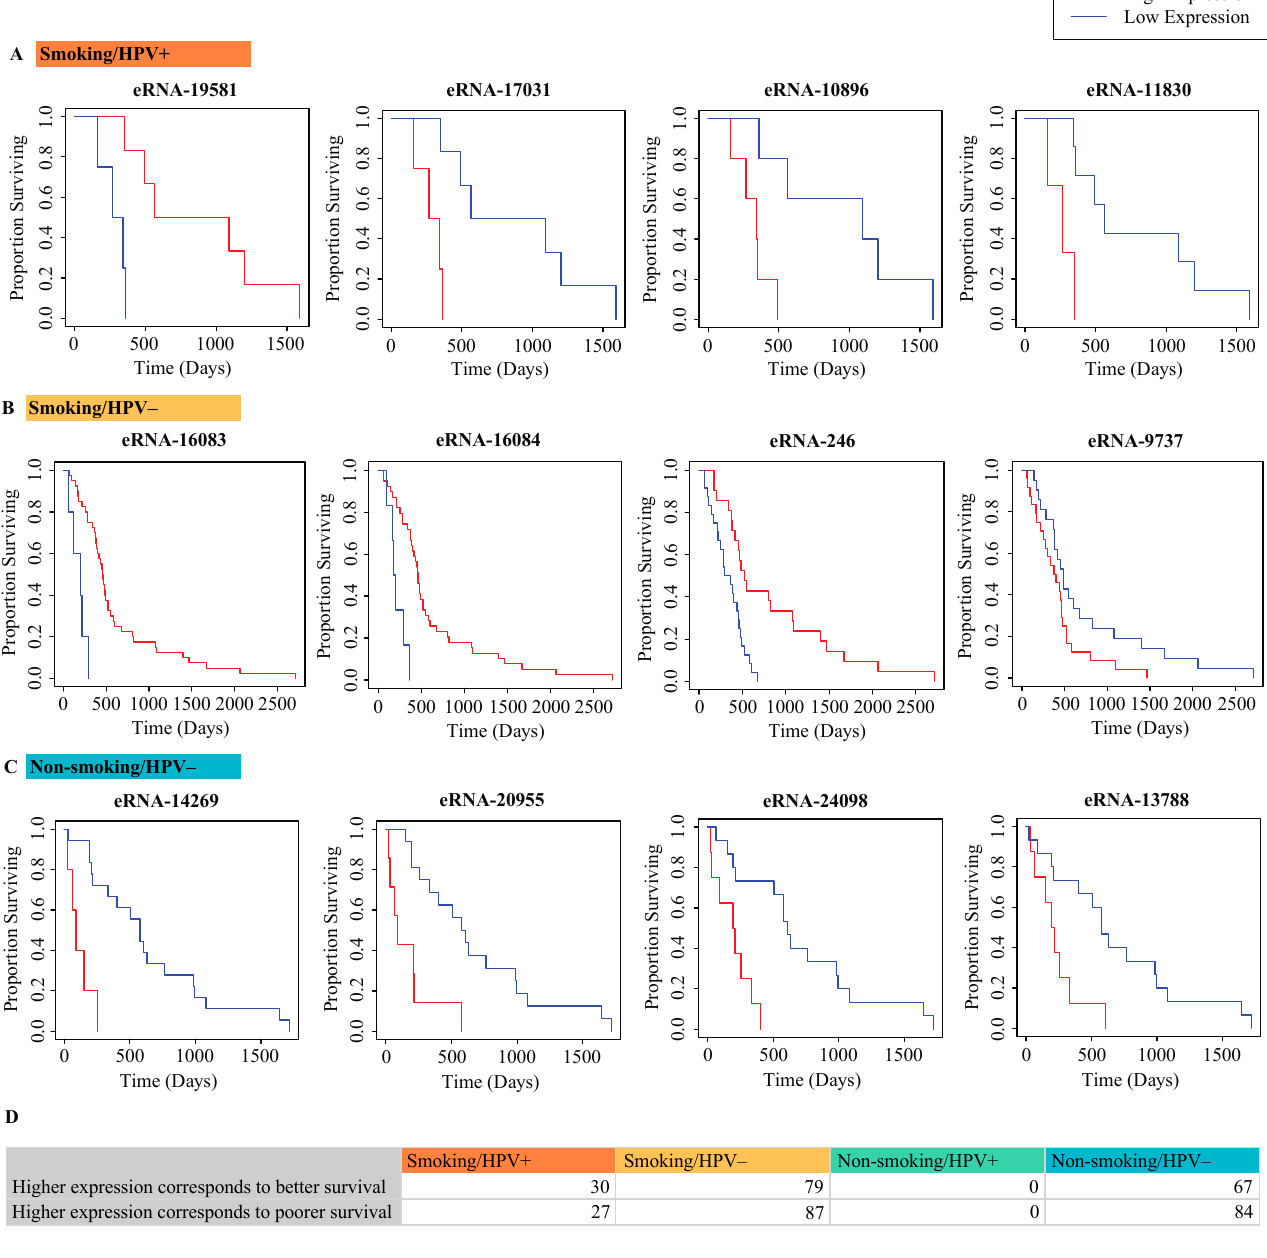
Figure 3. Correlation of differentially expressed eRNA in HNSCC cohorts to patient survival. Plots with the lowest p -values from each cohort have been presented. ( A ) Kaplan–Meier plots of differentially expressed eRNA in the smoking/HPV+ cohort. ( B ) Kaplan–Meier plots of differentially expressed eRNA in the smoking/HPV − cohort. ( C ) Kaplan–Meier plots of differentially expressed eRNA in the non-smoking/HPV − cohort. ( D ) The direction of correlation of significant microbes. The Cox proportional hazards regression model ( p < 0.05) was used to determine eRNAs correlated with survival.